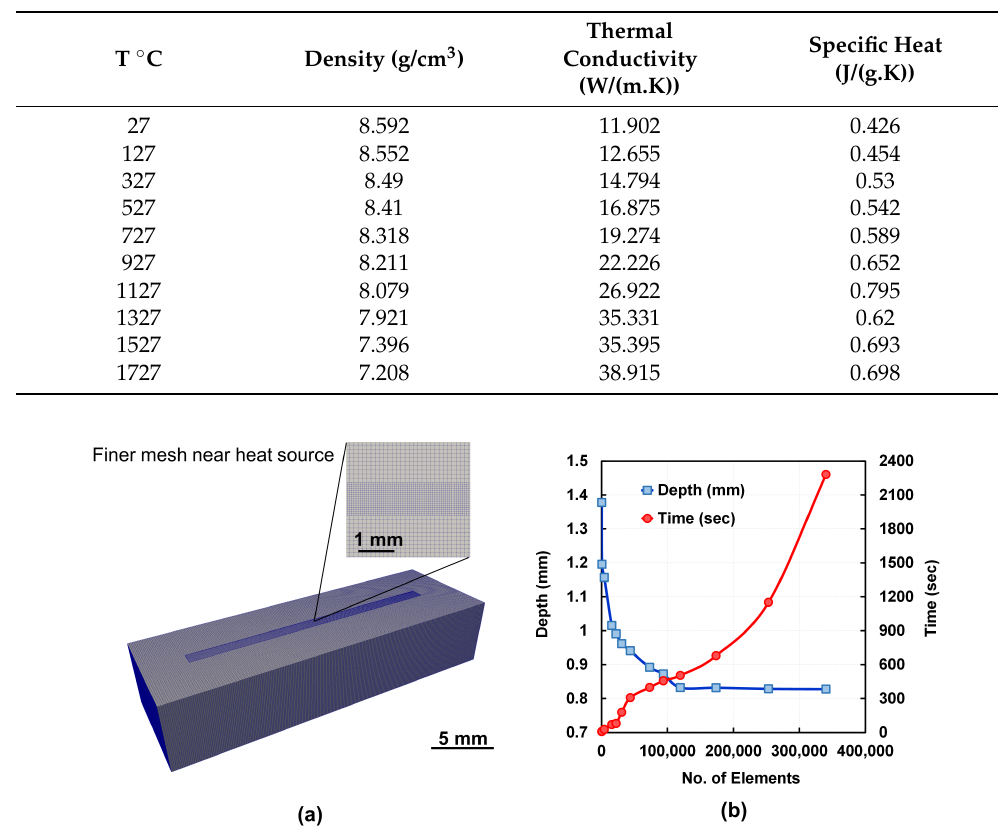
Figure 5. Simulation domain with boundary conditions. Table 2. Temperature dependent properties for CMSX-4 ® .